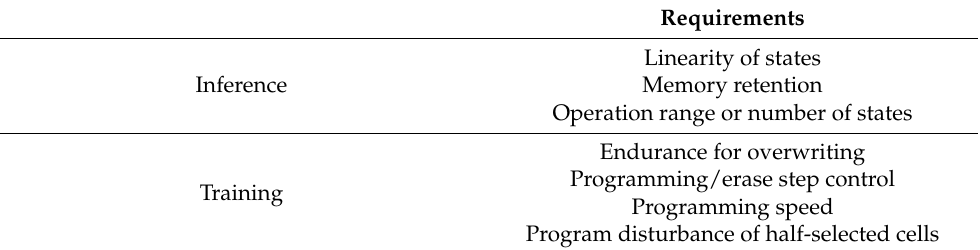
Figure 1. Schematic architectures of ( a ) von-Neumann and ( b ) in-memory computing. Table 1. Requirements for a multi-level memory cell used in a neural network.